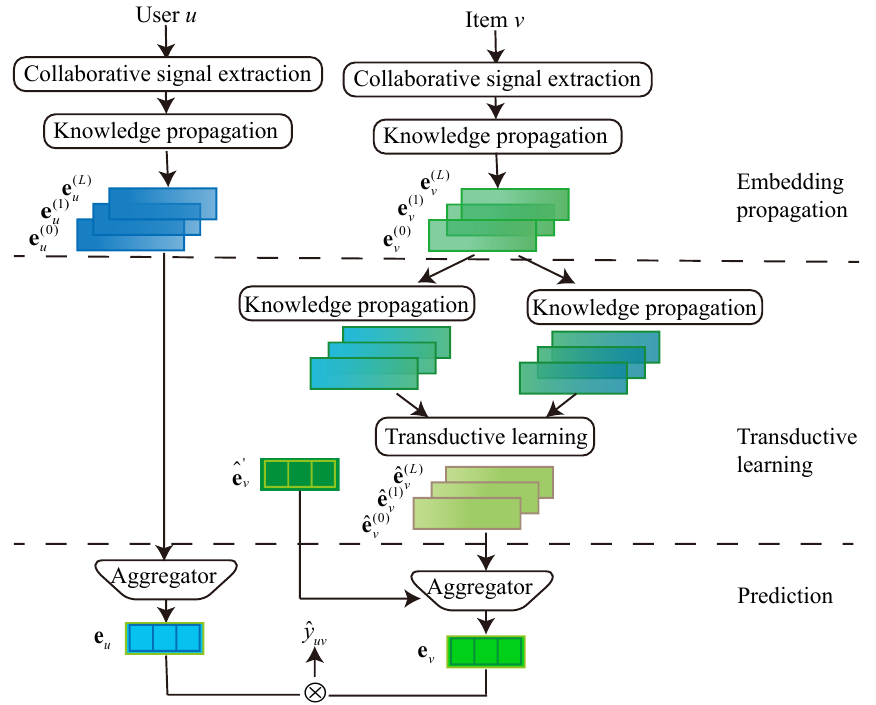
Figure 2. The illustration of the proposed KGET framework for